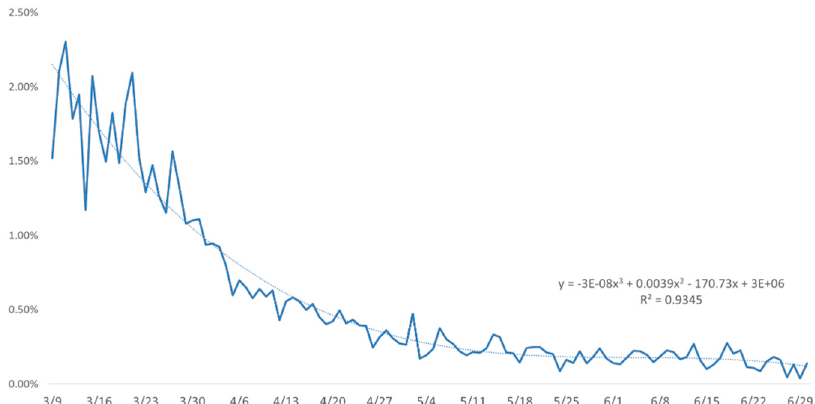
Figure 4. The plot of the fatality rate for diagnosed patients.